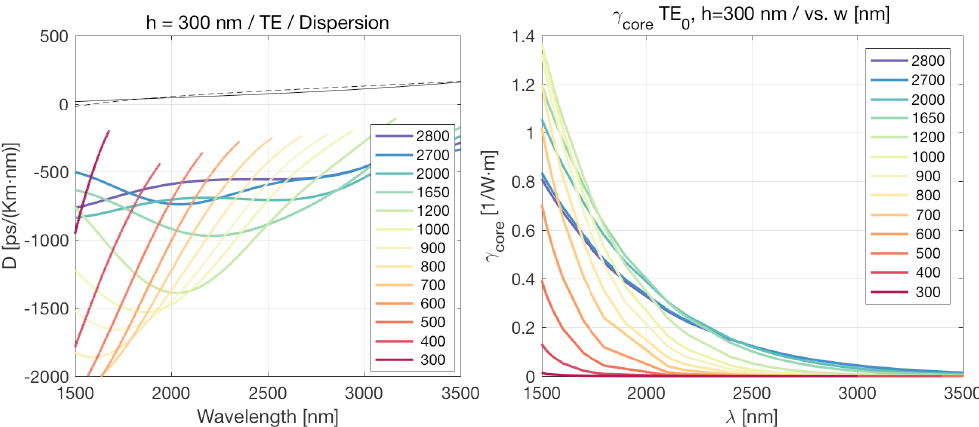
Figure A2. Enlarged view of the dispersion parameter, and non-linear propagation parameter, vs. wavelength, for different waveguide widths, for TE 0 .